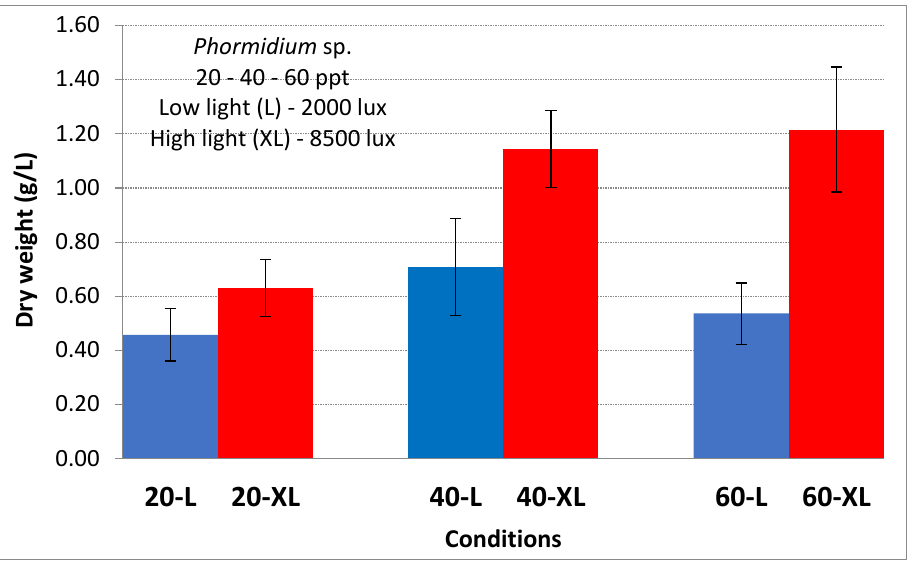
Figure 8. Yield in g dry weight per liter, of the cultures of Phormidium sp. at all treatments of combinations of salinity and illumination. Error bars represent the Standard Deviation. Symbols of the x -axis are explained in the caption inside the figure.